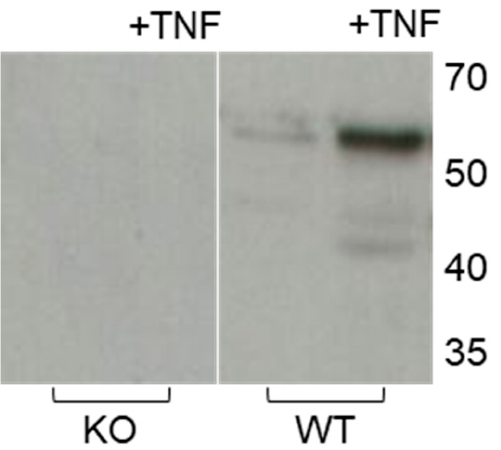
Figure 5. Effect of TNF- α on MMP-3 tissue levels in KO and WT skin after eight days of incubation in the absence or presence of TNF- α (+TNF) analyzed by western blot. Loading was normalized to the total protein (10 µg/lane) of the tissue extracts. Molecular weights in kDa are indicated to the right. Positions of protein markers in kDa are to the right. KO ( n = 4), MMP-3 knock-out skin; WT ( n = 4), wild-type control to KO skin.